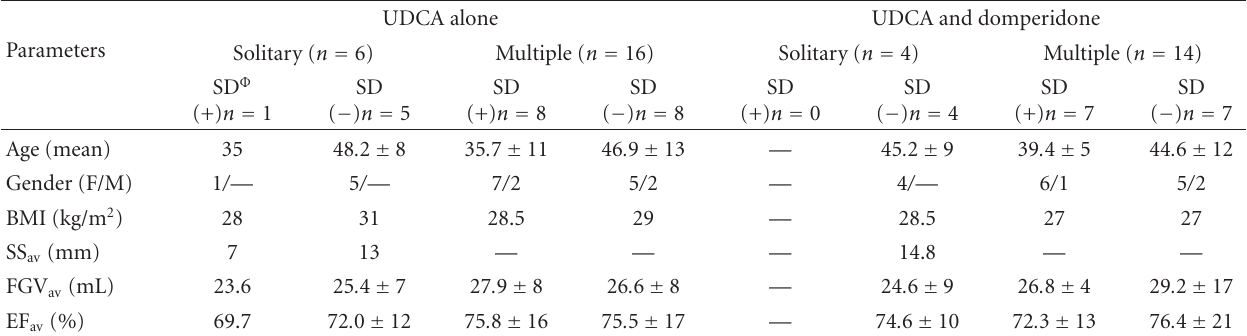
Table 2: Characteristics of the patients of whom stone dissolution was achieved or not ∗ .